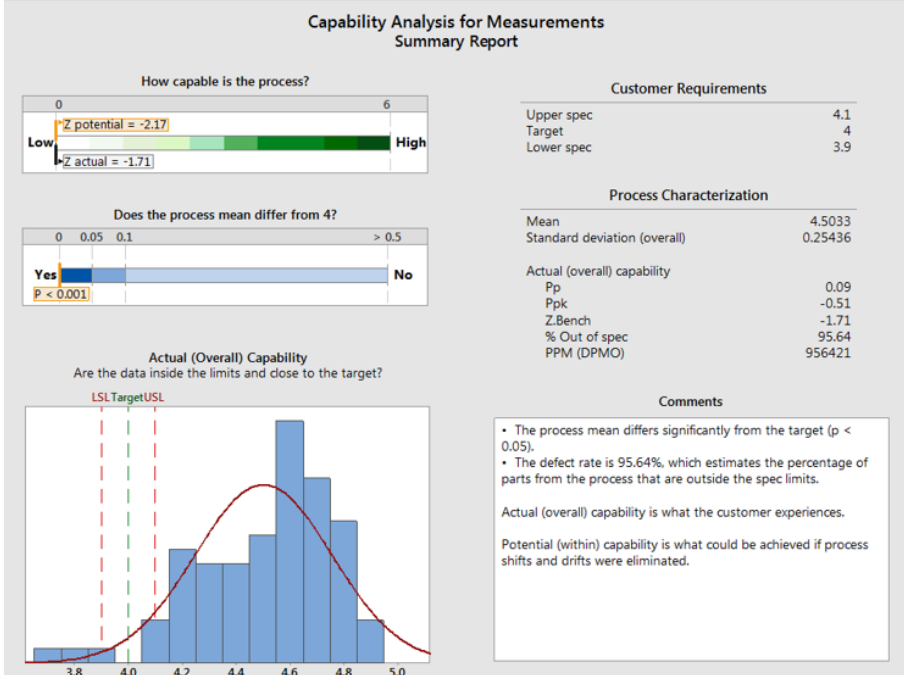
Figure 19. Analysis of the capacity for the measurements taken.